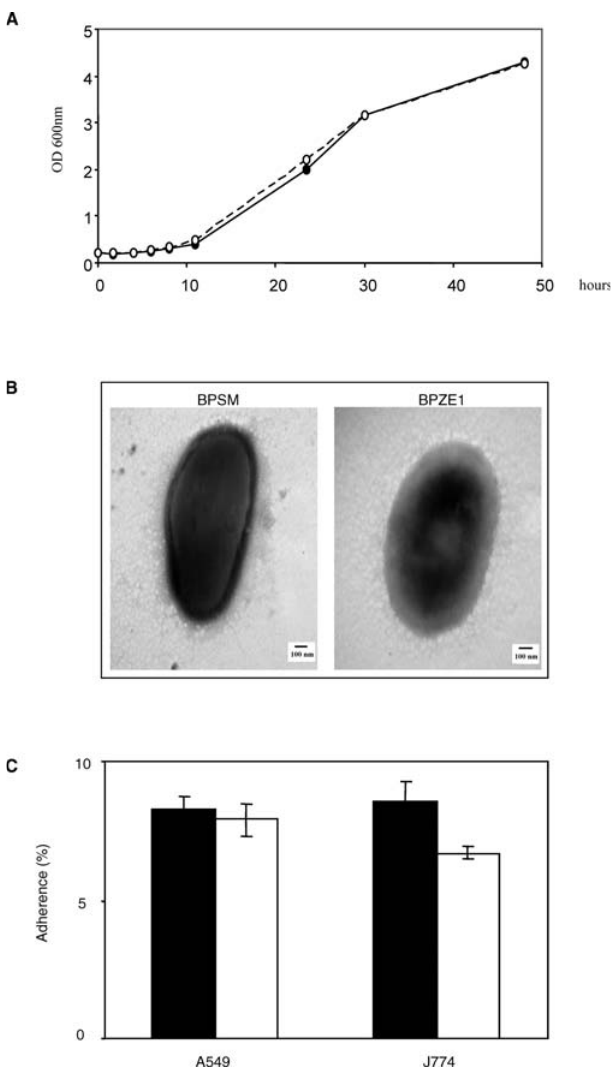
Figure 2. Phenotypic Characterization of B. pertussis BPZE1 (A) Growth rates of BPSM (solid line) and BPZE1 (dotted line) in liquid culture. (B) Electron micrographs representative of BPSM (left) and BPZE1 (right) grown in liquid medium for 24 h. (C) In vitro adherence of BPSM (filled columns) and BPZE1 (open columns) to human pulmonary epithelial A549 cells (left) and murine macrophage-like J774 cells (right). The results are expressed as means ( 6 standard error) of percentages of binding bacteria relative to the bacteria present in the inoculum from three different experiments. DOI: